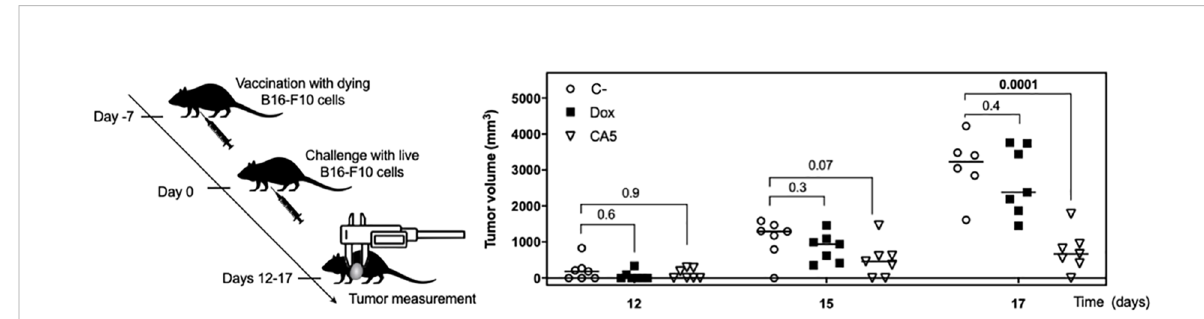
FIGURE 8 Vaccination with dying B16-F10 cells exposed to chromomycin A 5 confers mice resistance against live B16-F10 cells. At day -7, 1.8 × 10 5 cells pre-incubated for 24 h with 0.1 m M CA 5 (CA5) and 0.6 m M doxorubicin (Dox) were injected subcutaneously in the right axilla of mice. 7 days after vaccination (day 0) mice were challenged with 1 × 10 5 live B16-F10 cells in the left axilla. The mice of the negative control group (C-) were injected with saline solution at -7 day and live B16-F10 cells at day 0. N= 7 mice/group. Tumor growth was monitored until day 17. Differences between groups are expressed as p values indicated above the compared